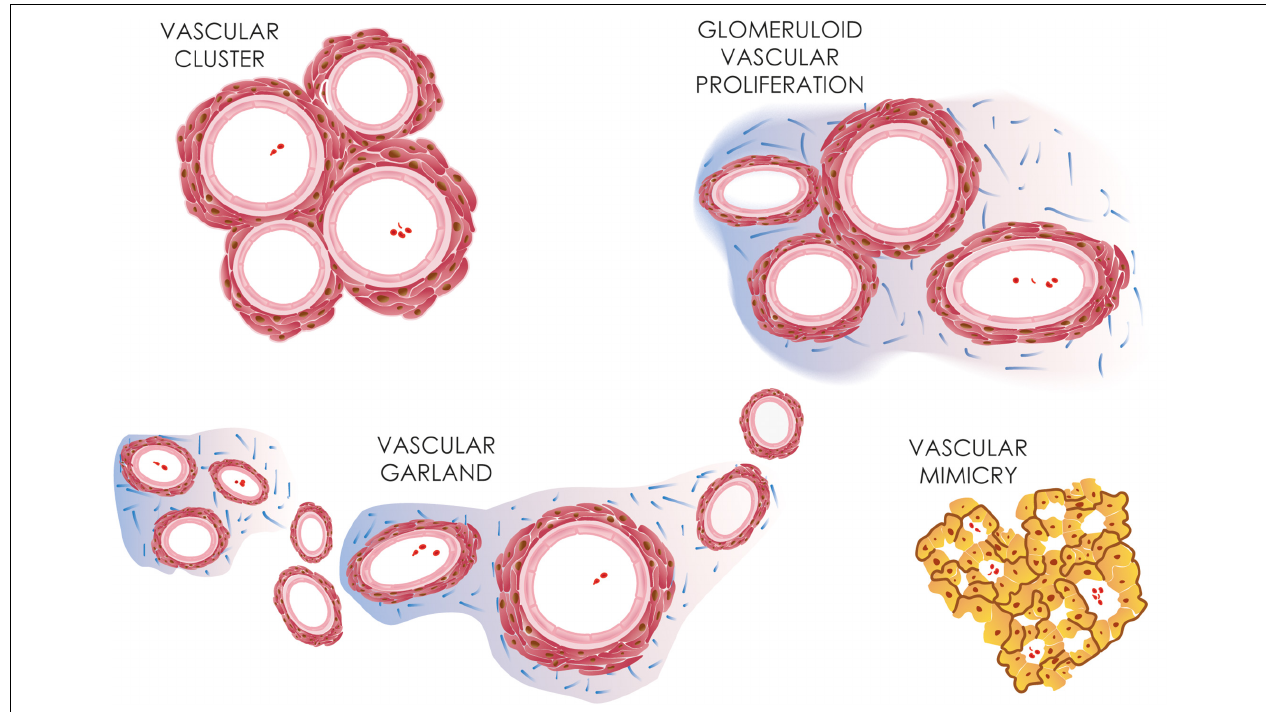
FIGURE 1 | GBM microvasculature. Different microvasculature types detected in GBM, including vascular clusters, glomeruloid vascular proliferations, vascular garlands, and vascular mimicry. Vascular mimicry, unlike other microvascular types, shows a lumen lined by tumor